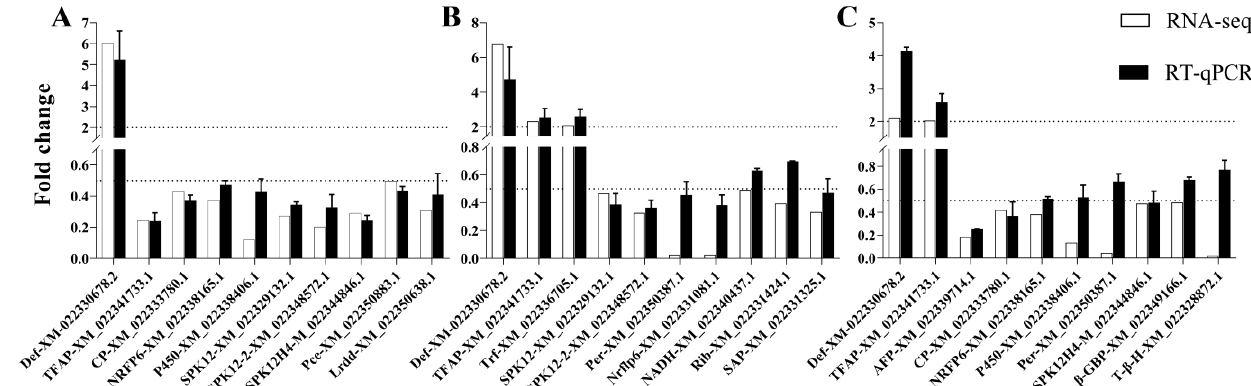
Figure 6. Transcriptomic data validation by RT-qPCR. RRSV-free BPHs were treated with Tween-80 (CK) or Metarhizium anisopliae YTTR (SF), and RRSV-carrying BPHs were also treated with Tween-80 (SV) or M. anisopliae YTTR (CI). ( A – C ) respectively means the expressions of DEGs among the three comparision groups of CI vs. CK, SF vs. CK, and SV vs. CK.